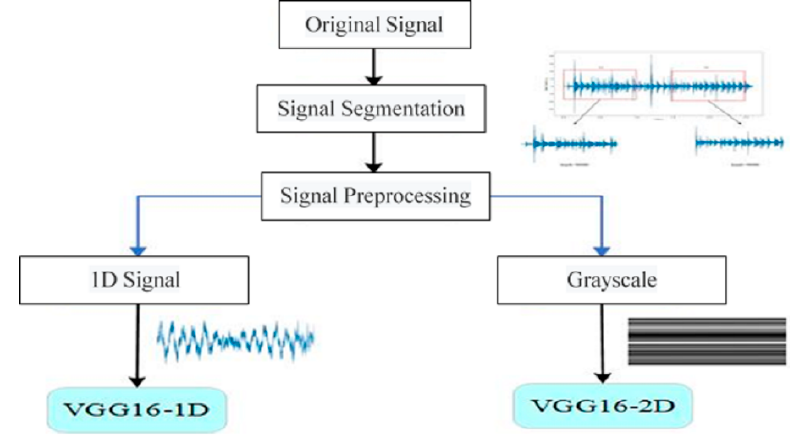
Figure 5. Algorithm flow chart.